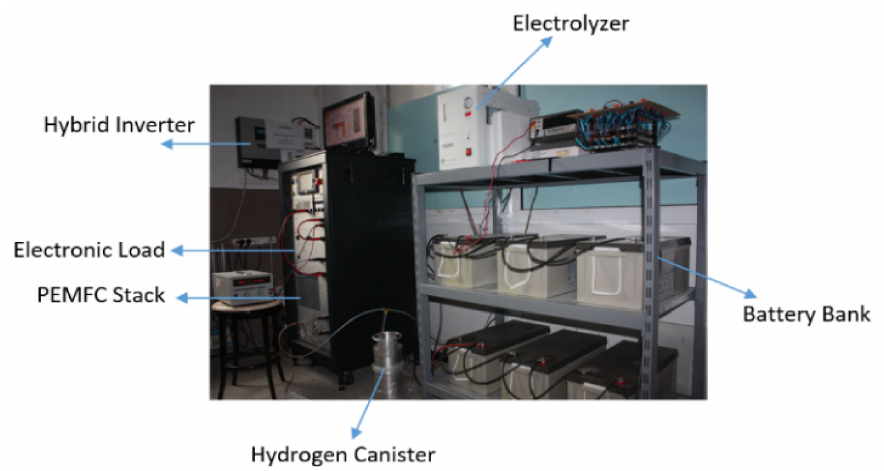
Figure 3. The DG system